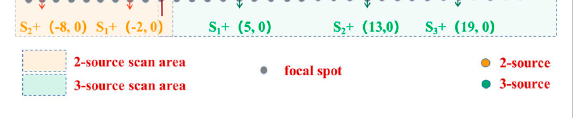
FIGURE 3 Experimental design for the imaging experiment. S+ represents the placement position of positive electrodes. Gray represents the focal spot of ultrasound. The yellow area indicates 2-sourcescanningpointarea.Andthegreenareaindicates3- source scanning point